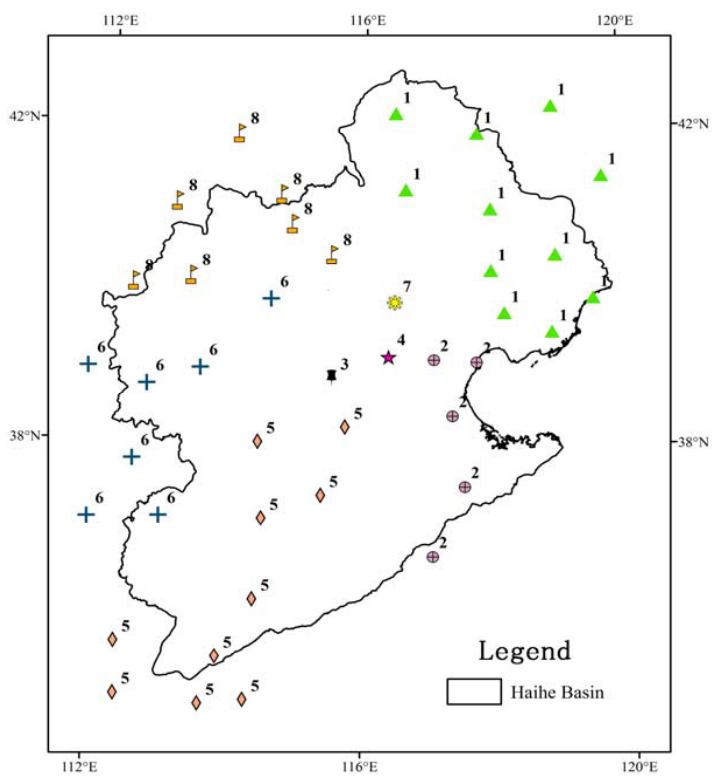
Figure 2. SOM clustering results and spatial distribution for the Haihe River Basin.